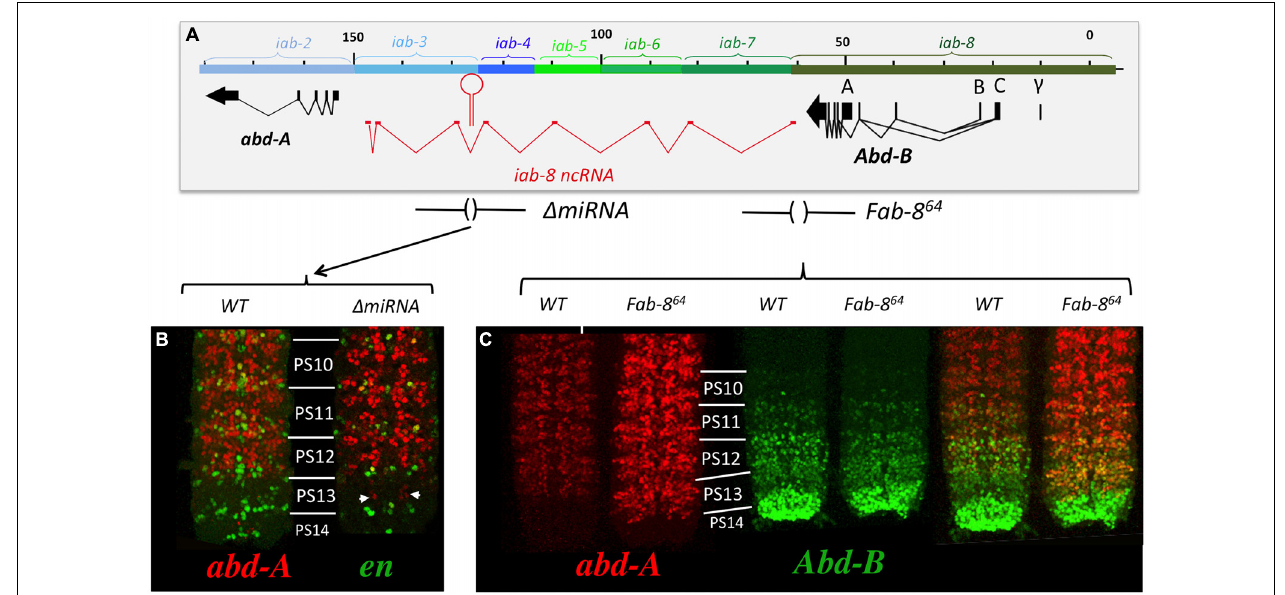
FIGURE 8 | abd-A is only de-repressed in a few cells in PS13 in Δ miRNA. Panel A shows the genomic map of the abdominal region of the BX-C as described in Figure 2 with the Δ miRNA deletion drawn above. CNSs were dissected out from stage 15 embryos Note in panel B that abd-A is